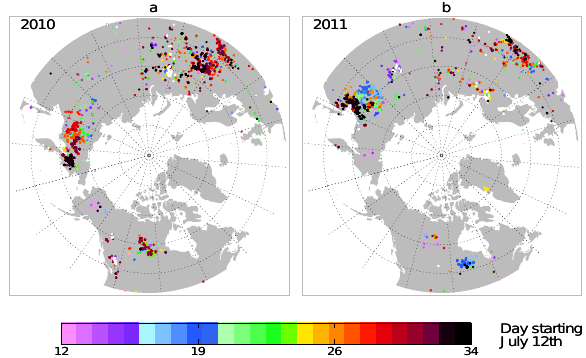
Fig. 2. Time and location of active fires during 12 July–3 August 2010 (a) and 2011 (b) , informed by the ATSR radiance measure- ments ( Mota et al., 2006). The colour denotes the day number, start- ing on 12 July. ATSR fire count data are from ATSR-WFA, from the Data User Element of the European Space Agency.